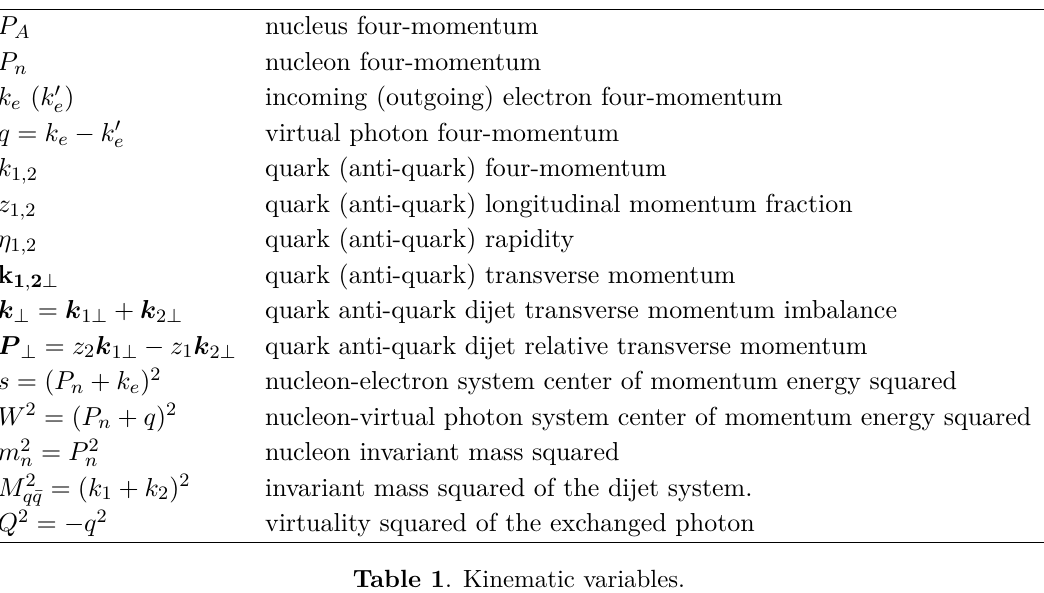
Table 1 . Kinematic